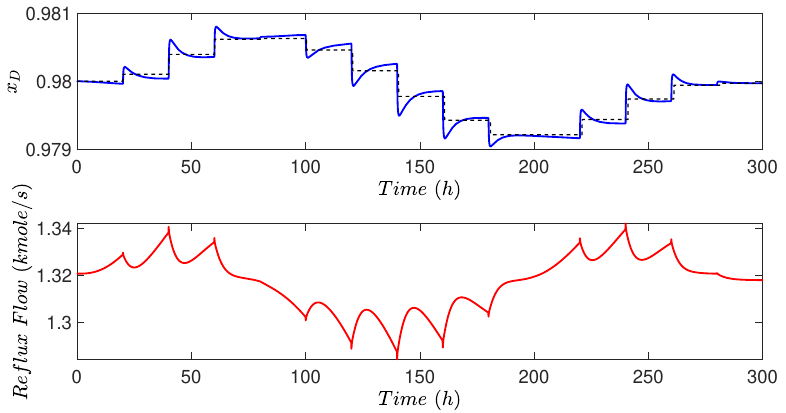
Figure 14. Controlled output x D and manipulated input reflux flow for the concentration controller CC in the distillation process under the proposed RTO scheme.